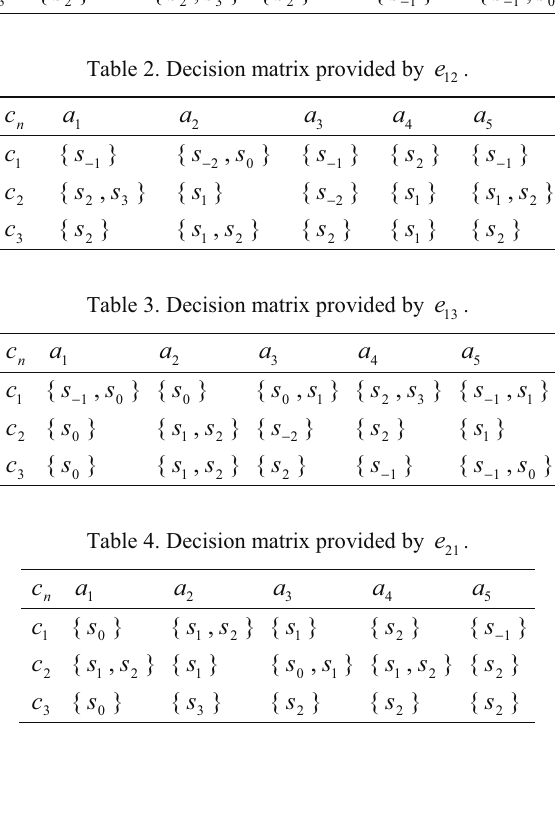
Table 2. Decision matrix provided by